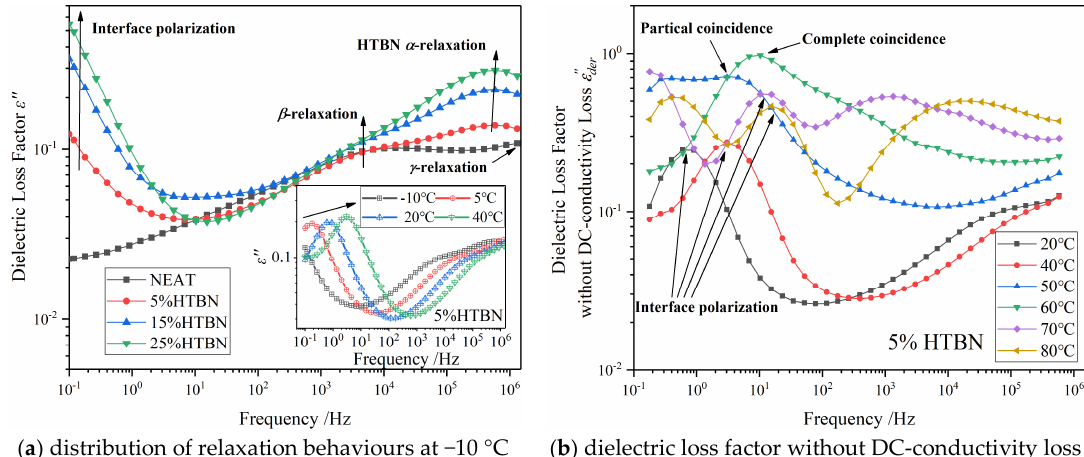
Figure 4. Frequency spectrum characteristics of dielectric loss factor: ( a ) distribution of relaxation behaviours at −10 °C; insert figure: temperature dependence of interfacial polarization in the sample with 5% HTBN content; ( b ) dielectric loss factor of the sample with 5% HTBN content without DC-conductivity loss in medium temperature region.